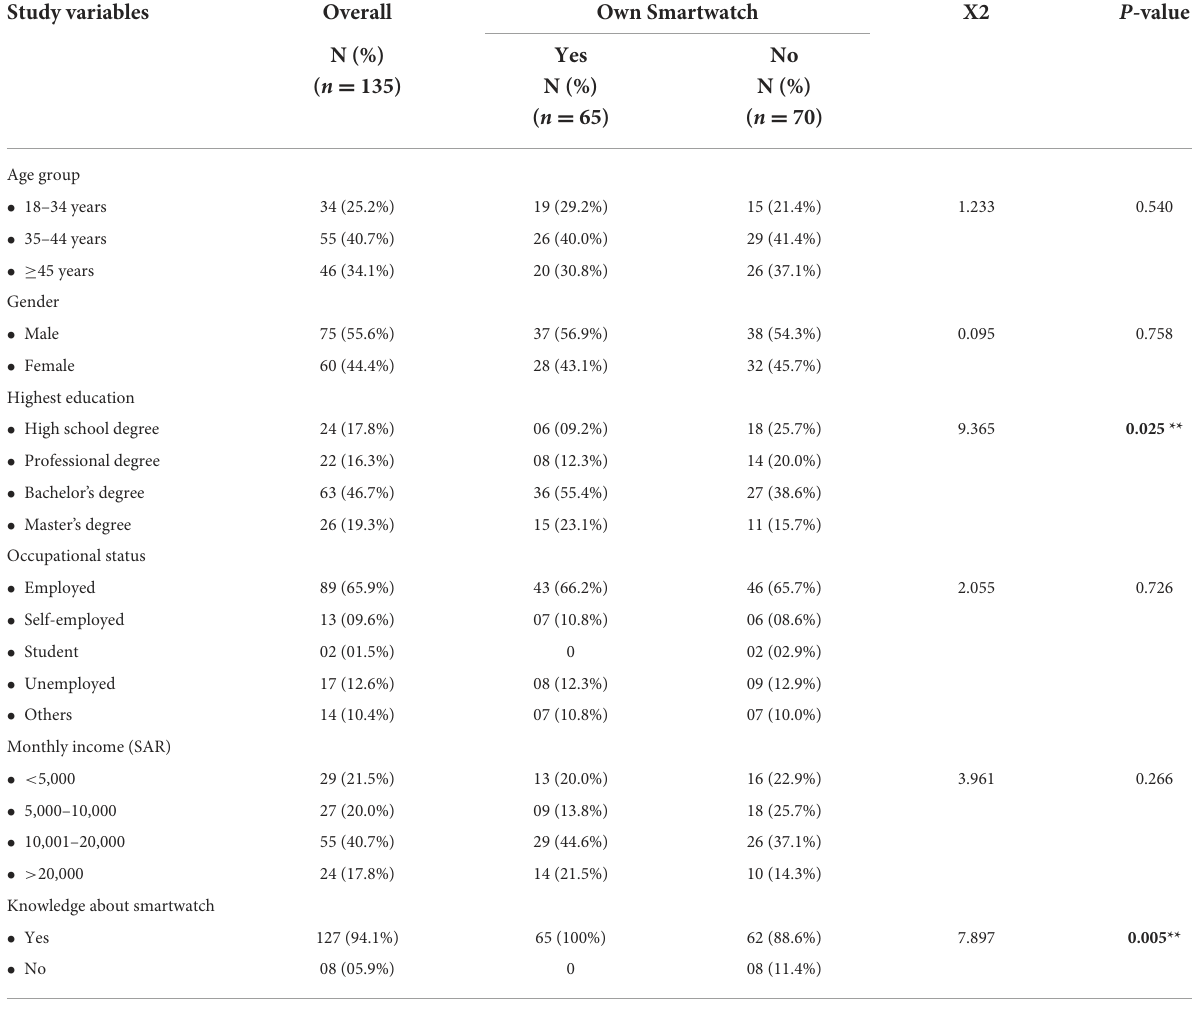
TABLE 1 Socio demographic characteristics of participants in relation to the usage of smartwatch. Study variables Overall